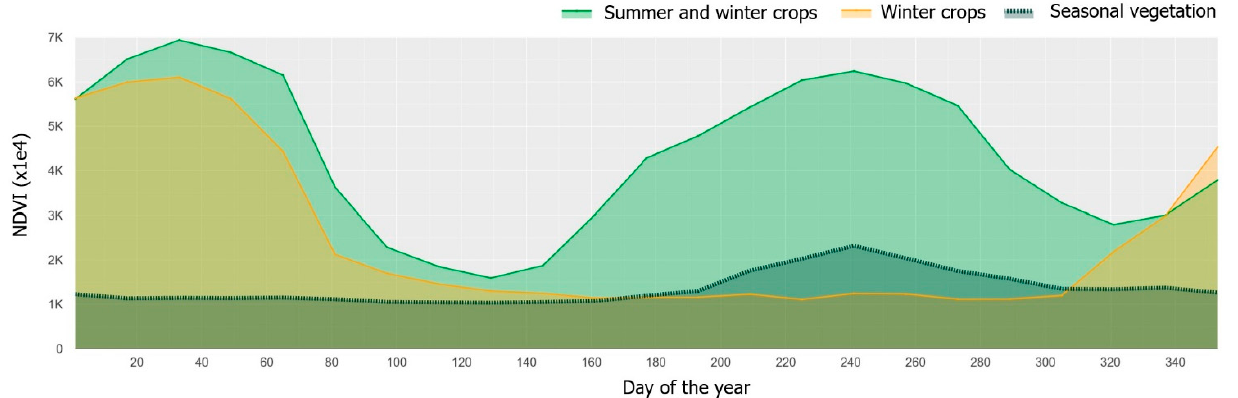
Figure 4. Average MODIS NDVI trends across the year in three distinct environments within the Cholistan region: light green line: irrigated lands with summer and winter crops; yellow line: winter irrigation in dahar desert mudflats; dark green line: seasonal desert vegetation in desert dunes and interdune areas. The GEE code used to reproduce the time series is provided in the Supplemental Material.